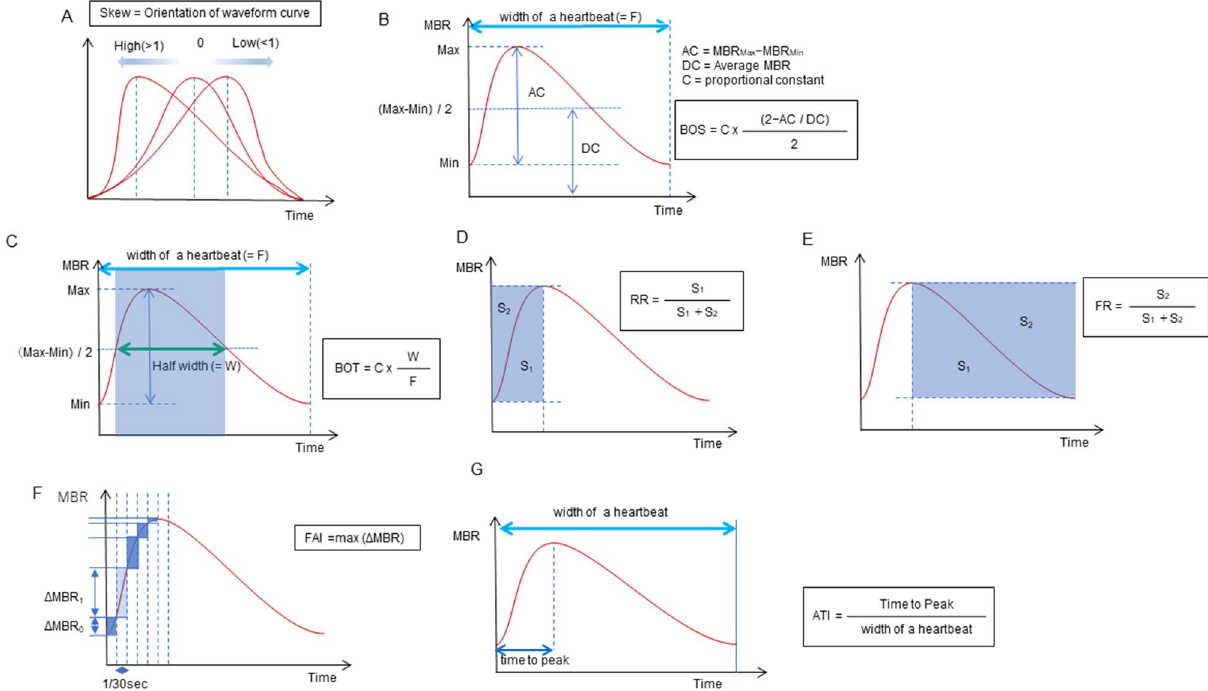
Figure 1. The pulse waveform analysis of the seven parameters. Skew represents the asymmetry of the waveform. A skew value of 0 describes a perfectly symmetrical waveform shape. If the peak comes faster and the distribution is leftward, the skew increases, and if the peak is slower and the distribution is rightward, the skew decreases ( A ). The blowout score (BOS) is considered an index of the blood flow that is maintained in one heartbeat (width of a heartbeat) and is calculated using the difference of the maximum and the minimum MBR as well as the average MBR. A high BOS indicates a high constancy of blood flow during the cardiac cycle ( B ). The blowout time (BOT) represents the ratio of the half-width in one heartbeat (width of a heartbeat). High BOT is an indicator of well-maintained perfusion during the cardiac cycle ( C ). The rising rate (RR) is the proportion of the area of S1 to S1 + S2 ( D ). The falling rate (FR) is the proportion of the area of S2 to S1 + S2 ( E ). The RR and FR characterize the steepness of the ascending and descending portion of the waveform curve, respectively. Higher values indicate a more sudden increase or decrease of MBR. The flow acceleration index (FAI) represents the maximum change in the increasing MBR in 1/30 s ( F ). The acceleration time index (ATI) is the ratio of the duration of the time to reach a peak (width to reach peak) in one heartbeat (width of a heartbeat) ( G